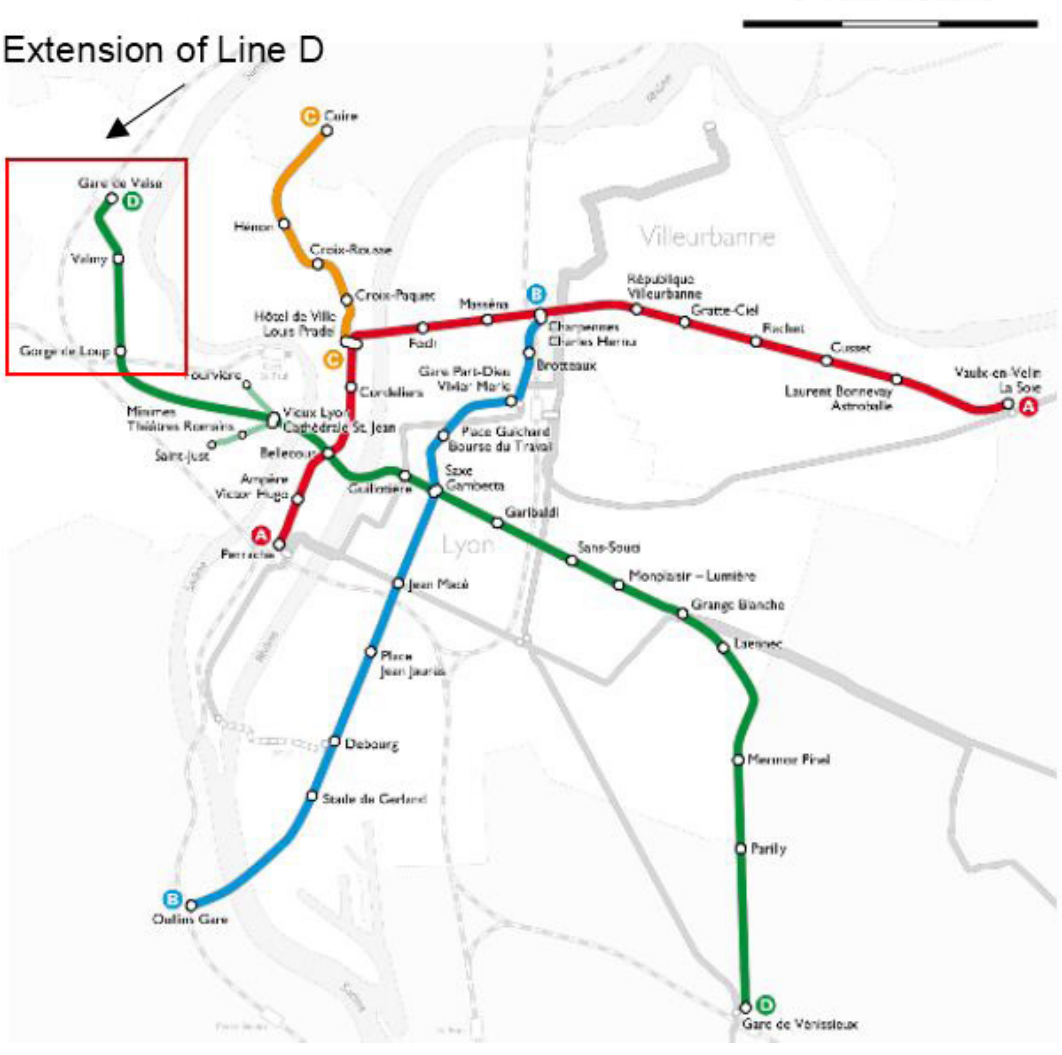
Figure 1: Lyon metro